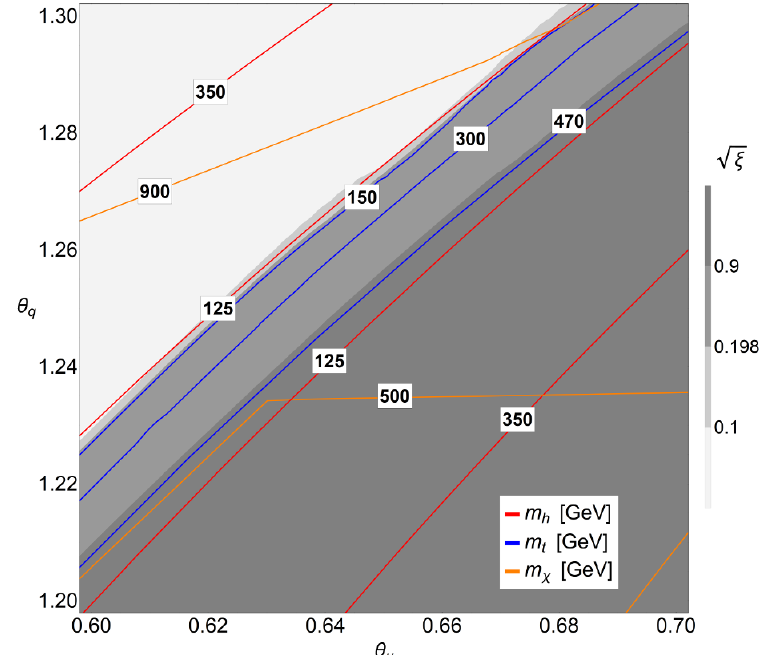
p Figure 2 . Contour plots of (cid:24) and the masses of the Higgs boson ( m H ), the top quark ( m t ) and the (cid:31) boson ( m (cid:31) ) as functions of the mixing angles (cid:18) u and (cid:18) q . The showed region is just a small portion of the explored parameter space where phenomenologically interesting points can be found. p The value (cid:24) = 0 : 198 corresponds to v = 246